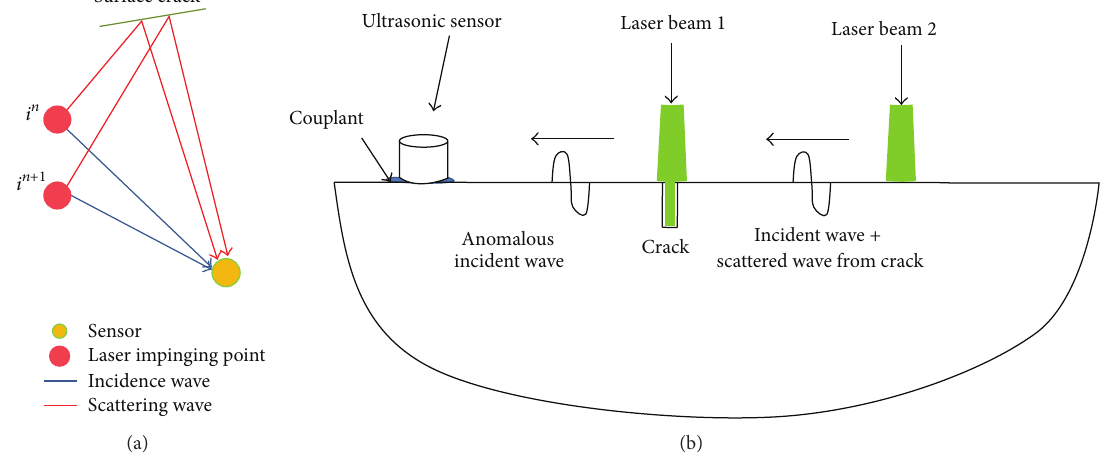
Figure 6: (a) Scattering wave generation mechanism of the beam impingement near the surface crack and (b) anomalous wave generation mechanism of the beam impingement within the surface